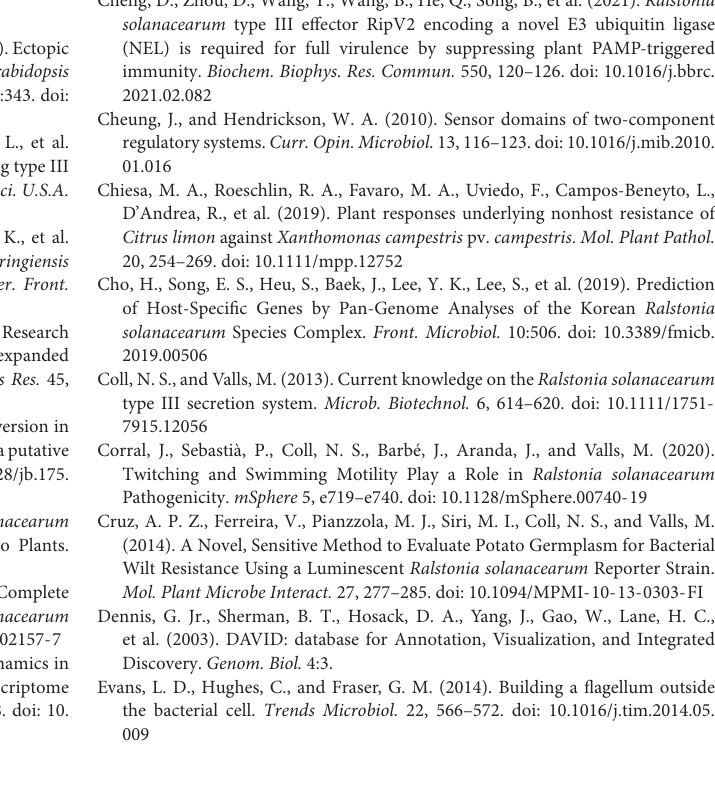
Supplementary Table 7 | GO enrichment analysis of PeaFJ1-specific genes compared with HA4-1. Supplementary Table 8 | TCS prediction results in R. solanacearum